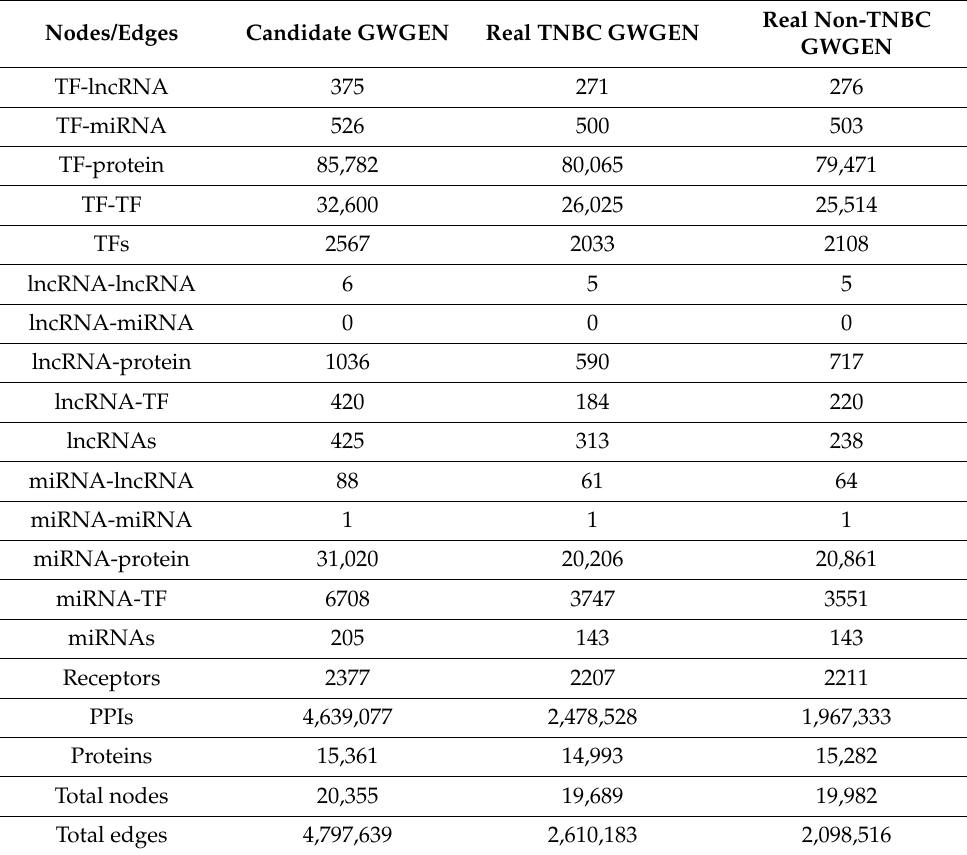
Figure 2. The core genome-wide genetic and epigenetic network (GWGEN) of non-TNBC. The grey lines indicate protein- protein interactions (PPIs); the blue lines denote transcriptional regulations by TFs and lncRNAs; and the orange lines represent post-transcriptional regulations by miRNAs. The numbers of receptors, proteins, TFs, miRNAs, and lncRNAs are 199, 1518, 184, 58, and 8, respectively. Table 1. The total number of nodes and edges in candidate GWGENs and identified real GWGENs of TNBC and